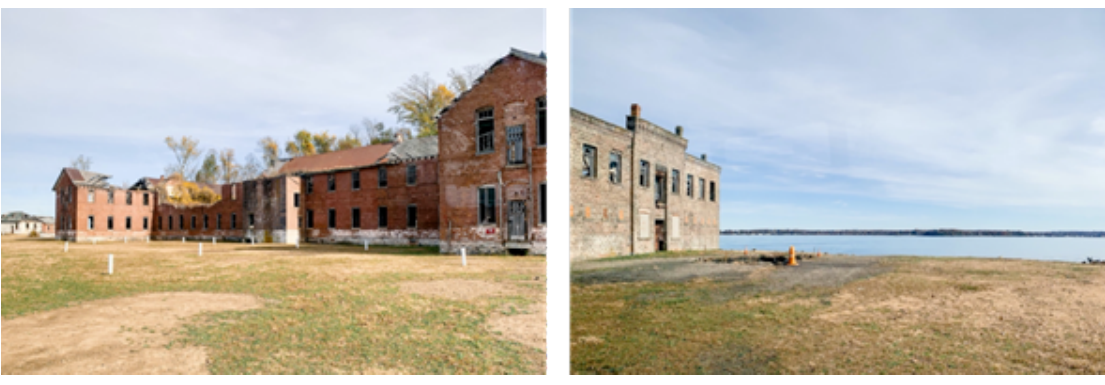
Figure 8. Decaying buildings on Hart Island, 2021 (Source: author)